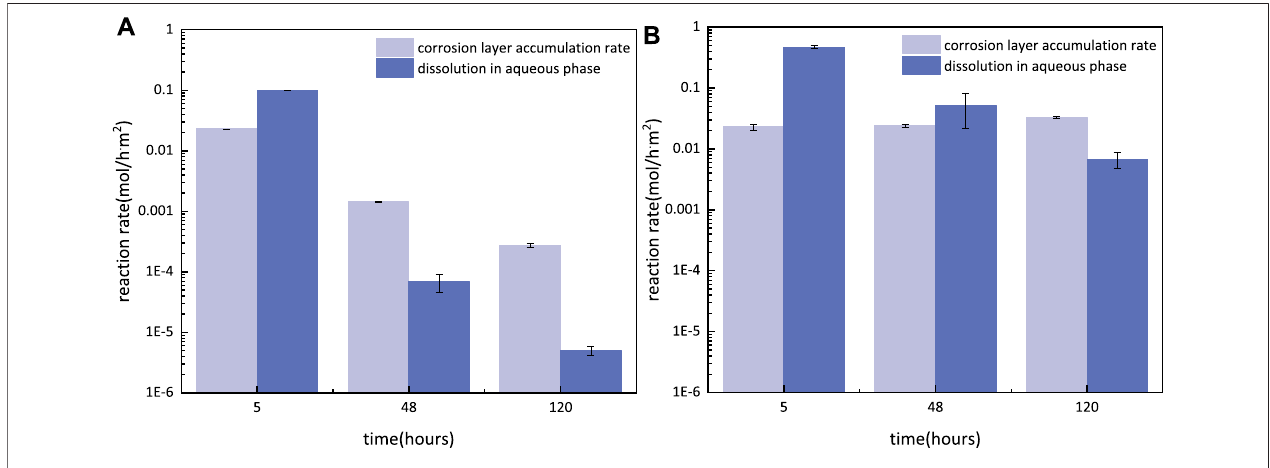
FIGURE 12 | CLAR and DR of S13Cr SS under the 180 ° C formate condition with N 2 /CO 2 saturated after 5, 48, and 120 h.